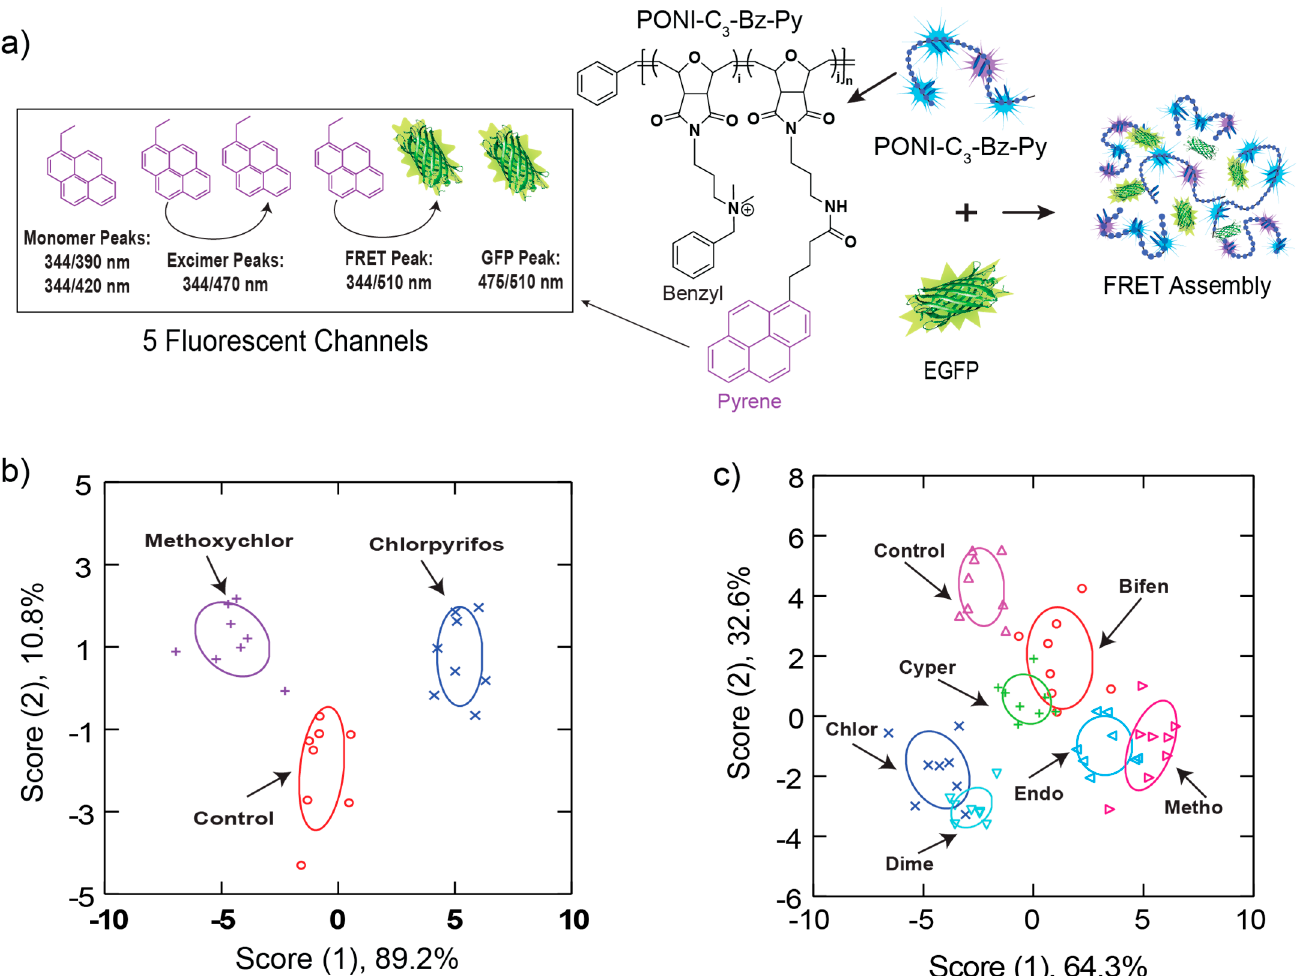
Figure 2. FRET-based sensor array for detecting cellular responses in macrophages induced by femtomolar level of pesticides. ( a ) The FRET-based sensor array was fabricated through a supramolecular assembly of PONI-C 3 -Bz-Py with EGFP, generating five fluorescence channels through fluorescence and FRET changes between the polymer and EGFP. ( b ) LDA classification of fluorescence responses from RAW 264.7 cells under methoxychlor or chlorpyrifos exposure (n = 8). ( c ) LDA classification of fluorescence responses from RAW 264.7 cells exposed to three classes of pesticides (n = 8). Reproduced with permission from [78]. Copyright 2022 Royal Society of Chemistry.